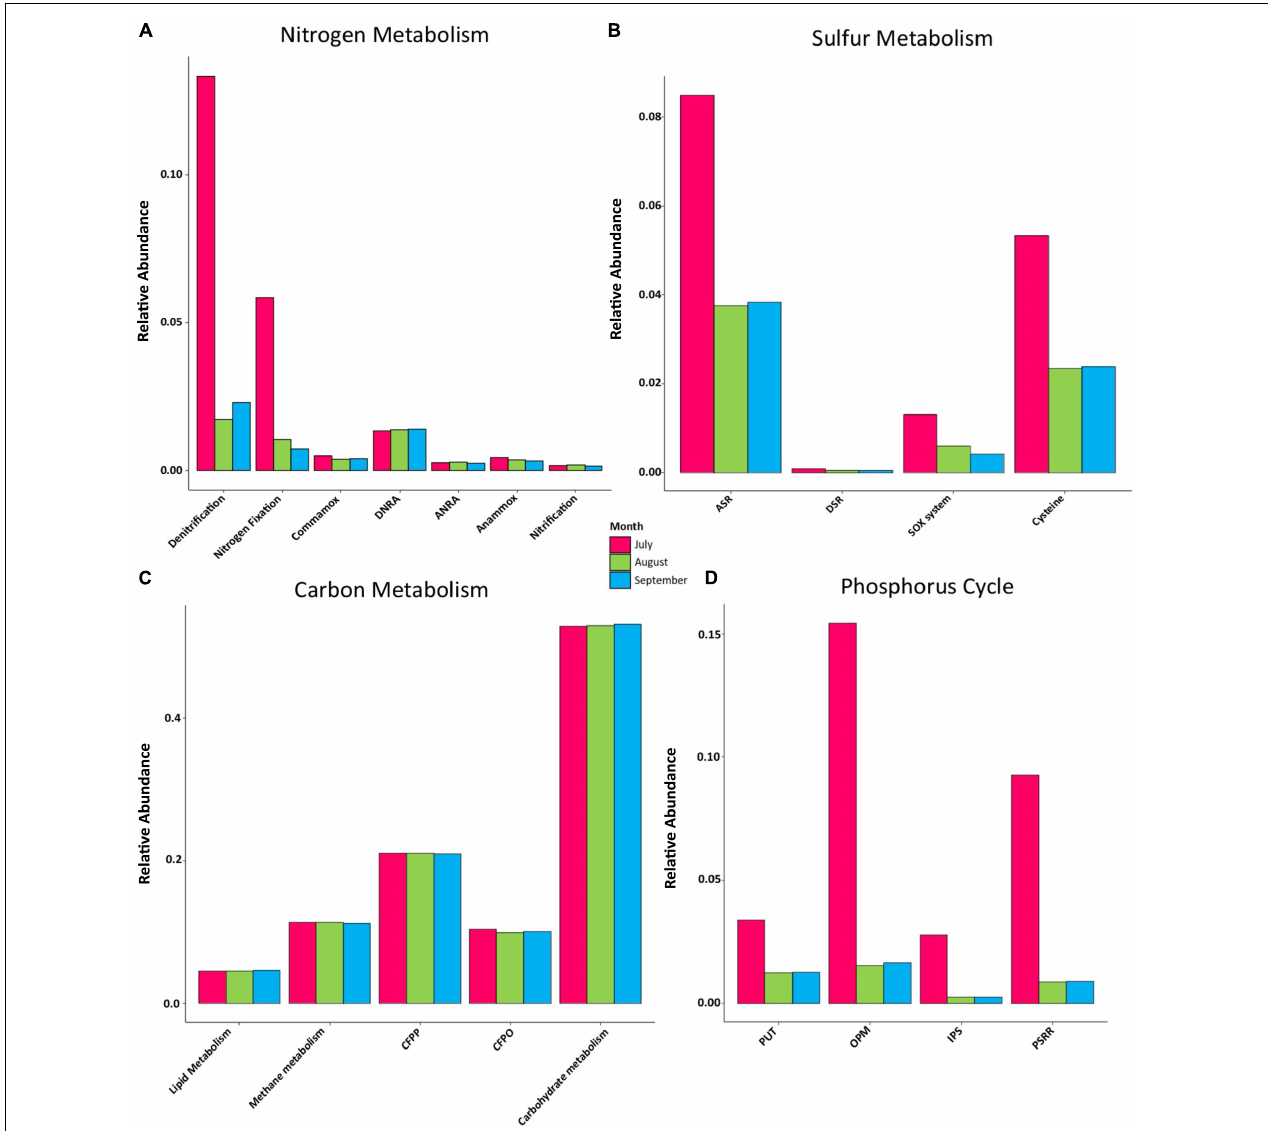
FIGURE 5 | Relative abundance levels of genes associated with major pathways in (A) nitrogen metabolism, DNRA, Dissimilatory nitrate reduction to ammonia; ANRA, assimilatory nitrate reduction to ammonia. (B) Sulfur metabolism, ASR, assimilatory sulfate reduction; DSR, dissimilatory sulfate reduction; SOX system, sulfur oxidation system. (C) Central carbon metabolism, CFPP, carbon fixation pathways in prokaryotes; CFPO, carbon fixation in photosynthetic organisms. (D) Phosphorus cycle, PUT, P-uptake and transport; OPM, organic P-mineralization; IPS, inorganic P-Solubilization; PSRR, P-starvation response